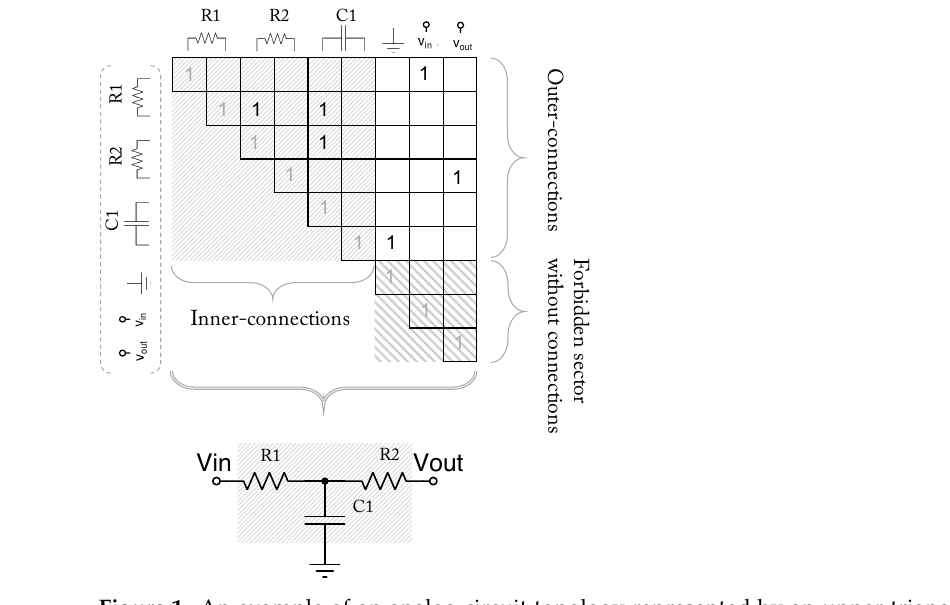
Figure 1. An example of an analog circuit topology represented by an upper-triangular incident matrix. Every logical one connects two terminals of listed components or outer terminals [33].